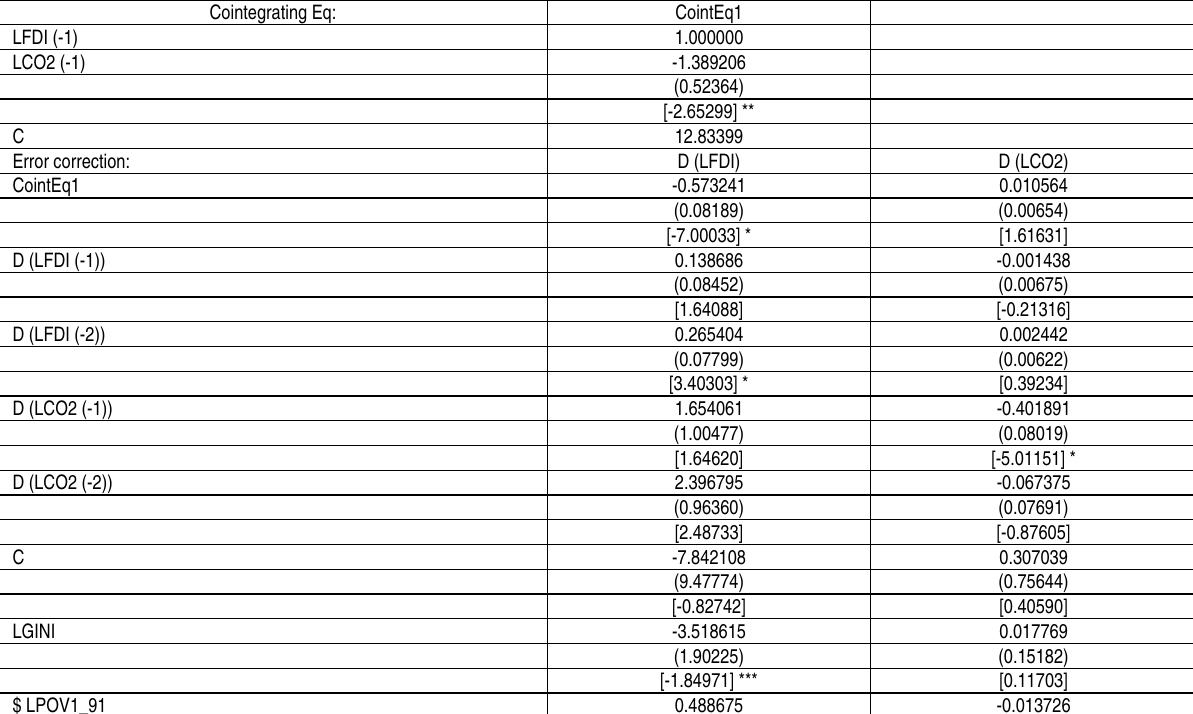
Table 7. The ECM for variable LCO2 Cointegrating